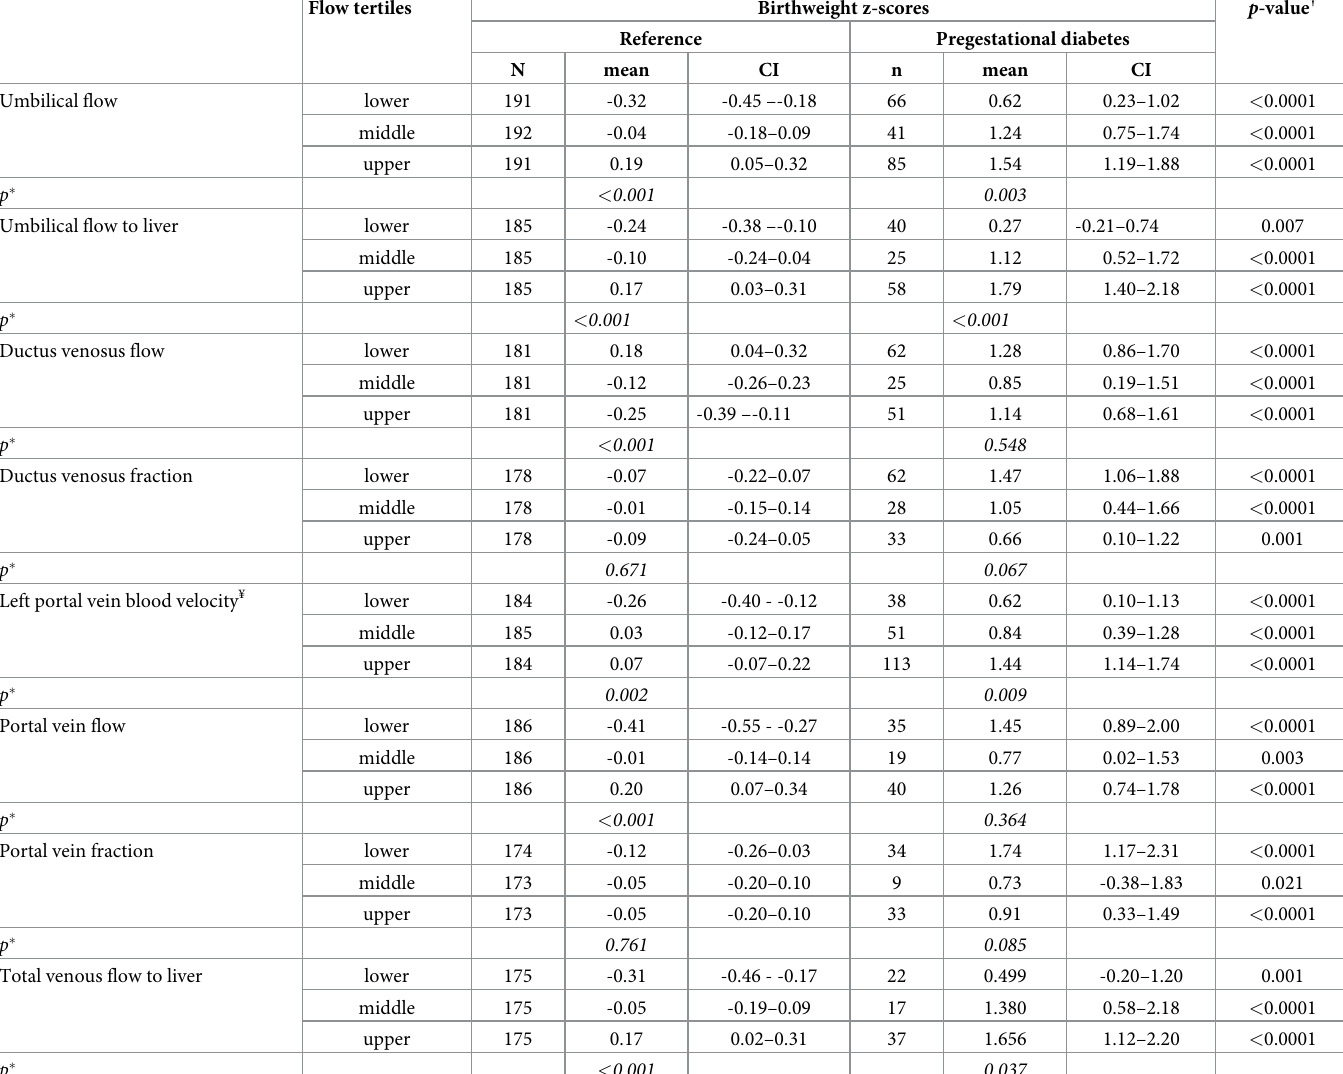
Table 3. Birthweight z-scores according to fetal flow tertiles in the reference and the pregestational diabetes mellitus population (160 and 49 participants,